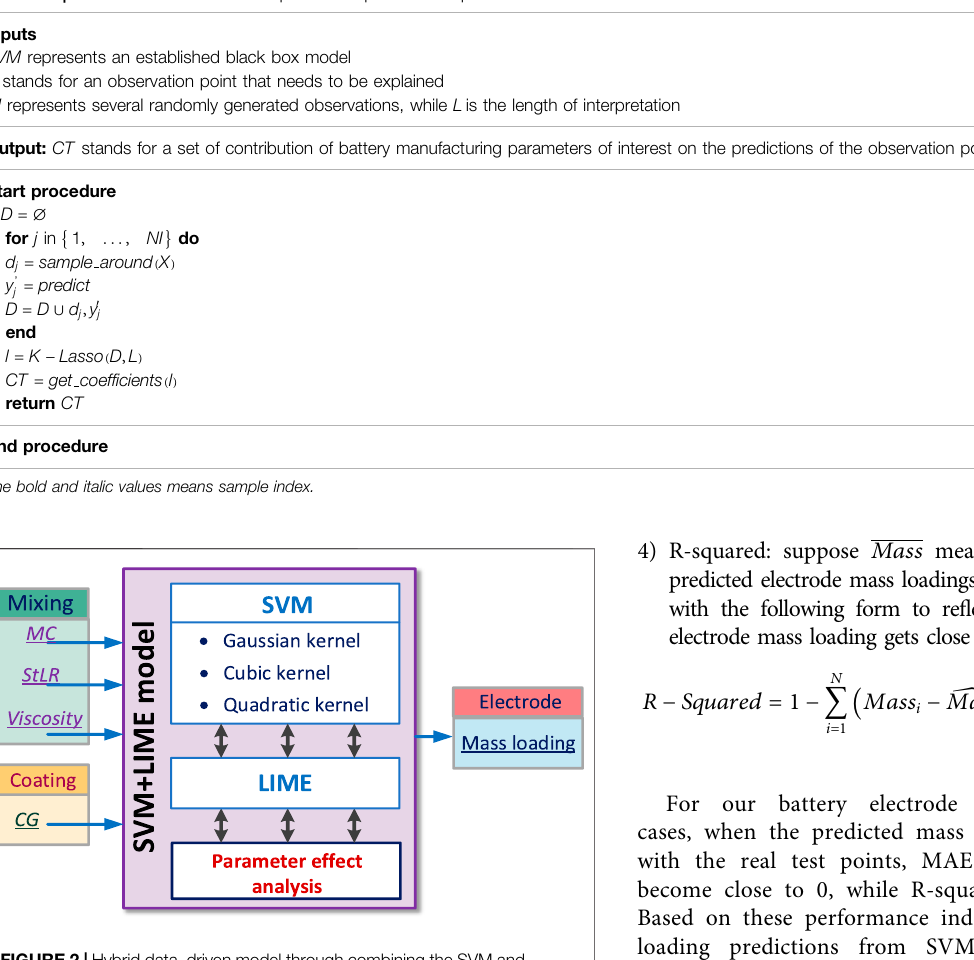
FIGURE 2 | Hybrid data – driven model through combining the SVM and LIMEtopredictbatteryelectrodemassloadingandanalyzeparametereffects.